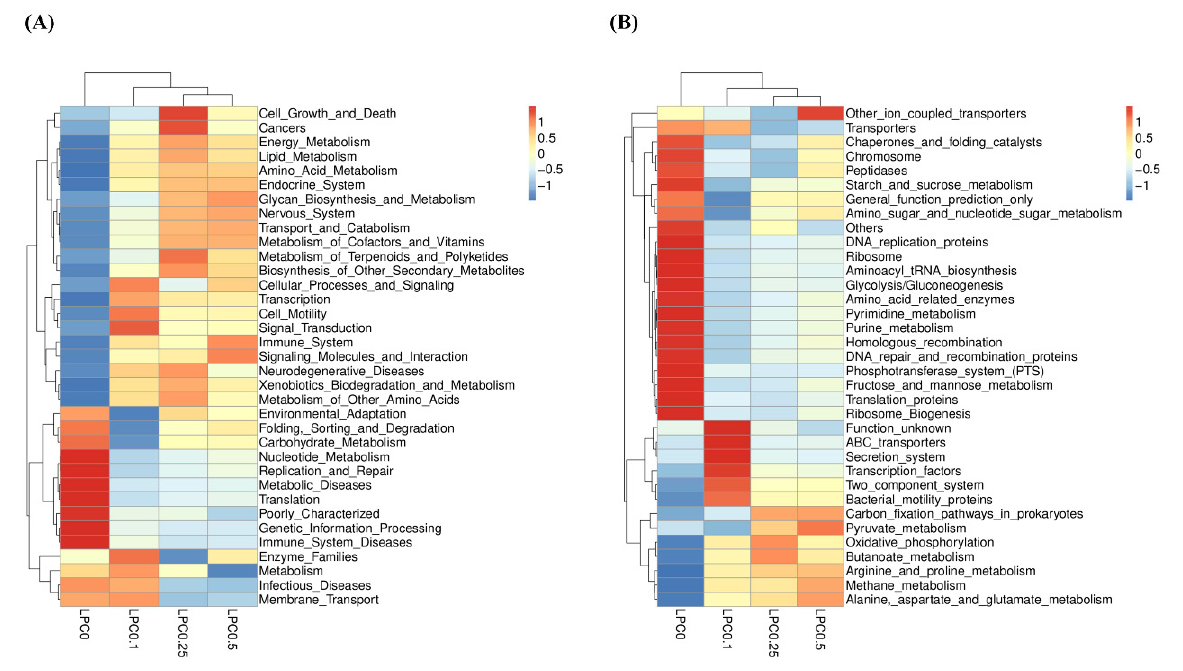
Figure 9. The functional profile predicted at level 2 ( A ) and level 3 ( B ) KEGGs Orthologs.